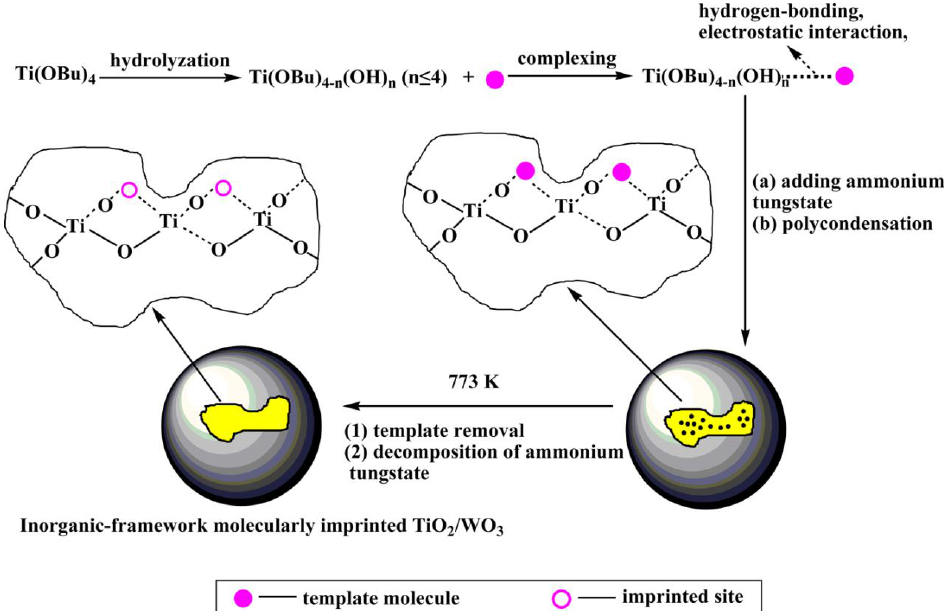
Figure 4. Route for preparation of inorganic–framework molecularly imprinted TiO 2 /WO